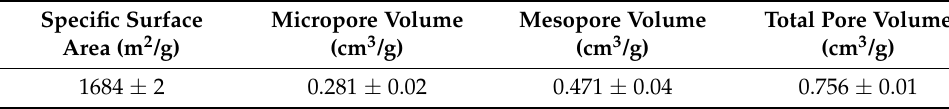
Table 4. Characteristics of the CPAC used in this